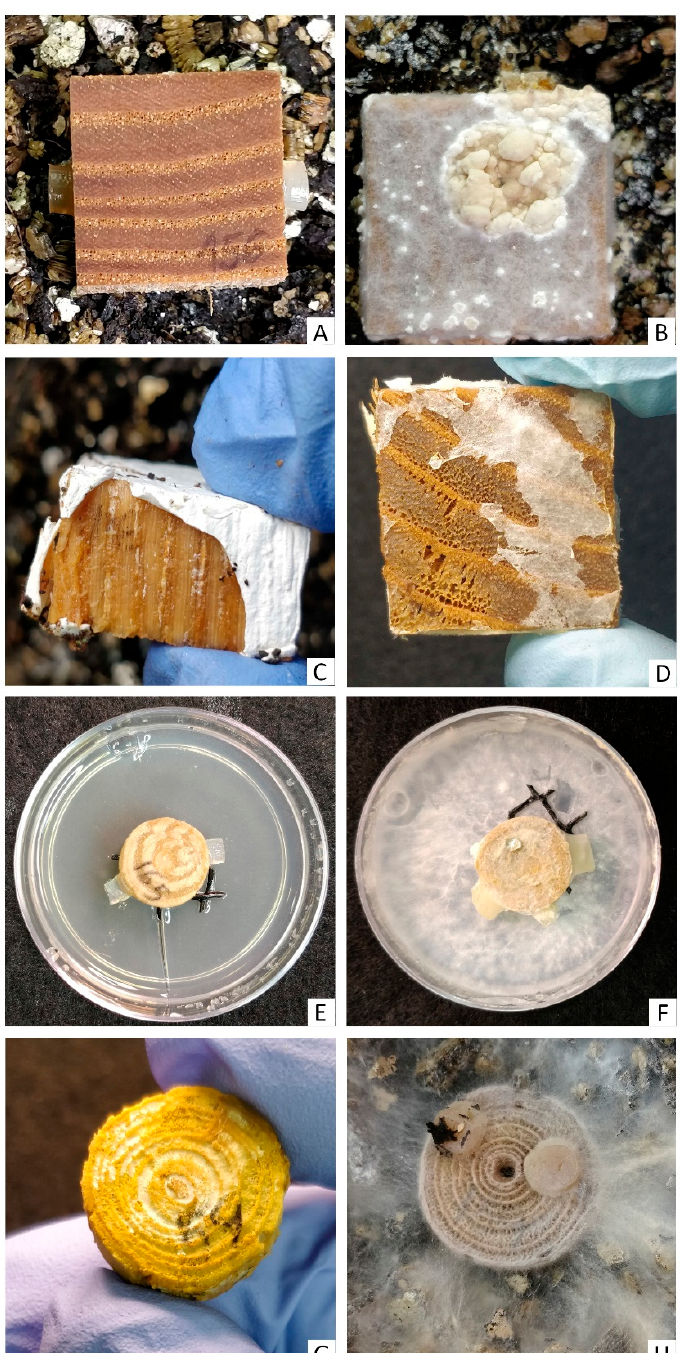
Figure 2. Control and inoculated wood blocks after 6 months of incubation. ( A ) Control treatment of a wood block from soil microcosm. ( B ) Growth of Peniophora cinerea (EAB 49-16) mycelium on a wood block from a soil microcosm. ( C ) Removal of mycelium of Trametes versicolor (EAB 43-3) from decayed block. ( D ) Advanced decay of a wood block inoculated with Peniophora cinerea (EAB 49-16). ( E ) Control treatment of sapwood disc in agar microcosm. ( F ) Growth of Phlebia radiata (EAB 60-6) mycelium on sapwood disc in agar microcosm. ( G ) Advanced decay on sapwood disc inoculated with Irpex lacteus (EAB 49-12). ( H ) Advanced decay of sapwood disc by Peniophora pseudoversicolor (EAB